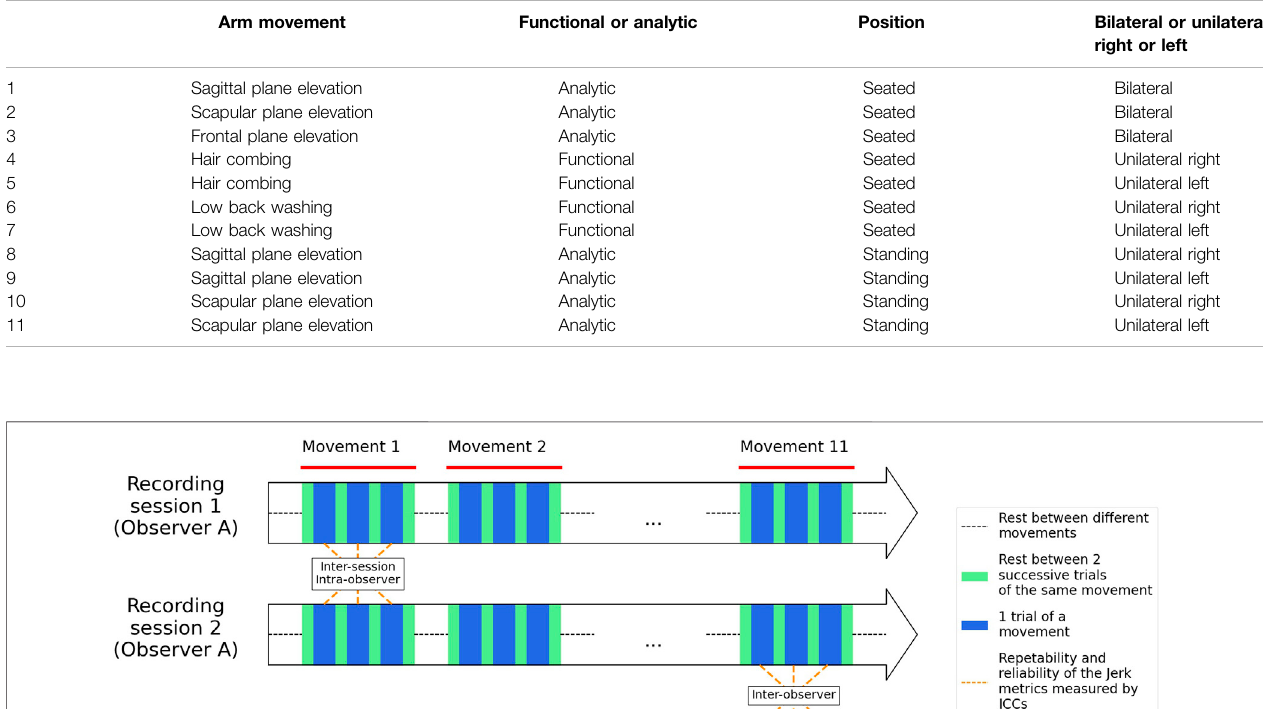
TABLE 1 | List of the movements performed during a recording session, presented in execution